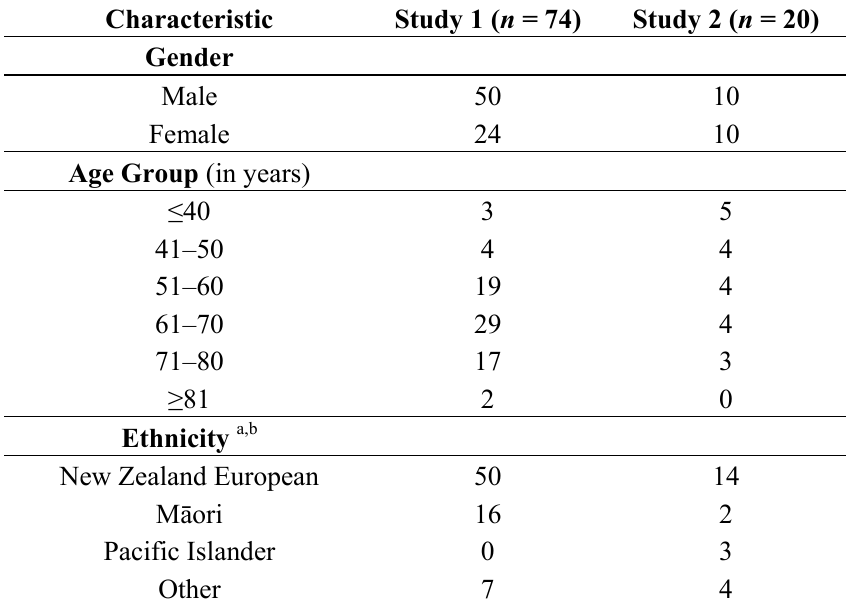
Table 2. Participant demographics for the formative research (Study 1) and pilot (Study 2).